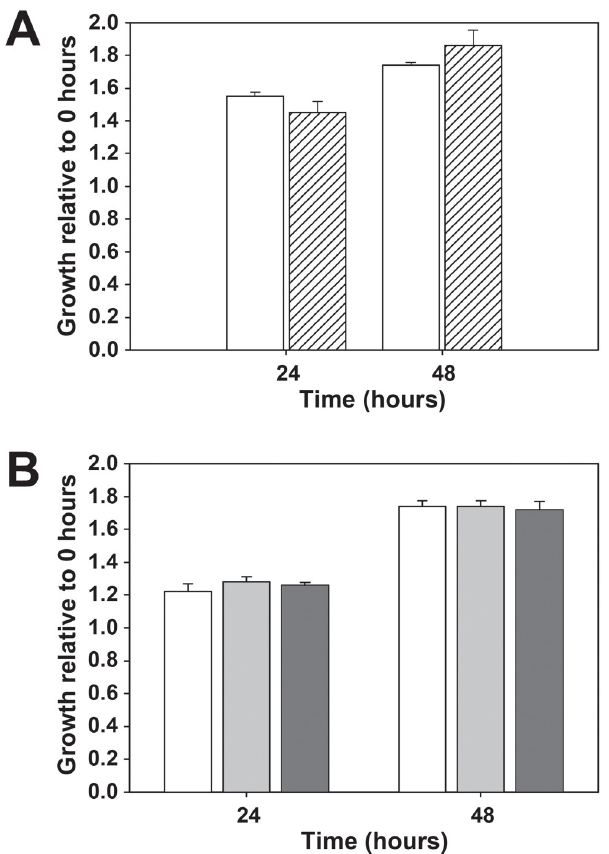
CE11 Δ rad51 ko3 , dark gray